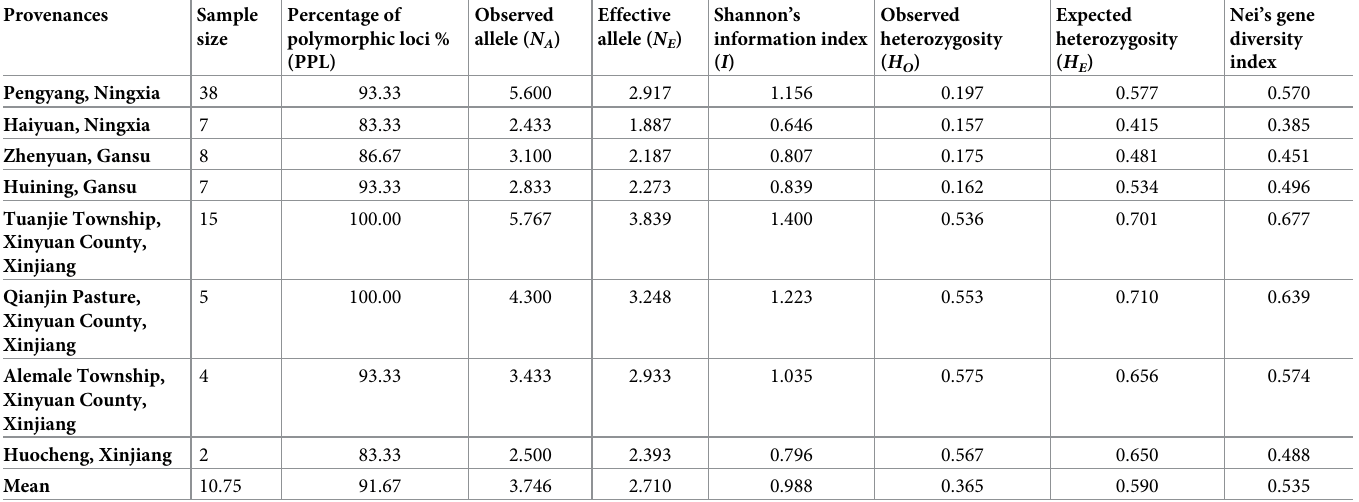
Table 2. Genetic diversity of P . armeniaca var. Ansu from different provenances. Provenances